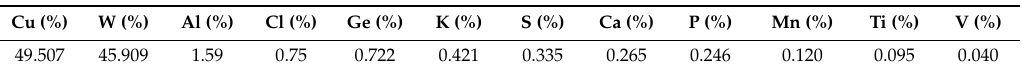
Table 3. Chemical composition by weight (wt %) of the mobile contacts according to the chemical analysis